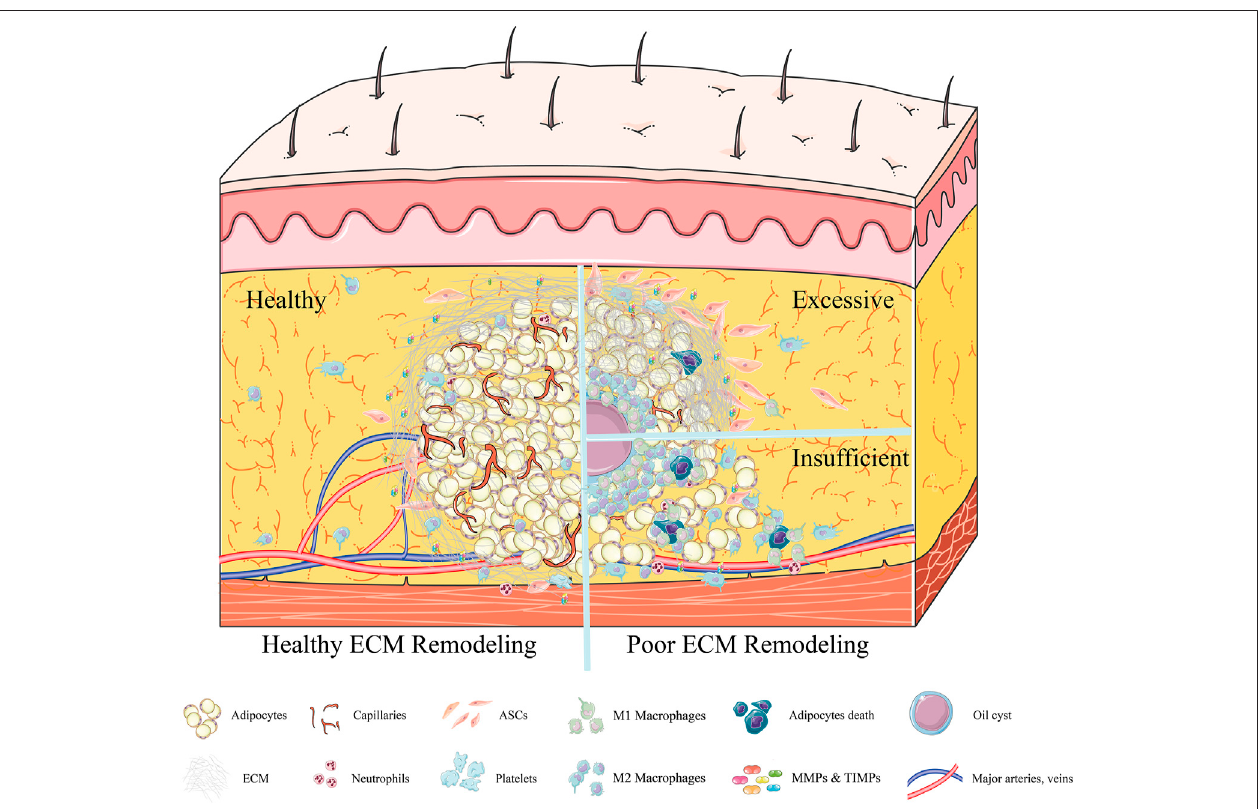
FIGURE 2 | Adipose ECM remodeling ≥ 7 days after fat grafting. In an environment of healthy adipose ECM remodeling, the establishment of a new vascular network is accompanied by gradual thickening of the fragile collagen fi bers, forming a complete ECM framework ( left ) . Almost all adipocytes were embedded in this newly formed cytoskeleton, after which the in fl ammation subsides gradually. By contrast, in an environment of poor adipose ECM remodeling ( right ) , excessive deposition ofECM isobserved, increasing adipose tissue stiffness ( right, above ).Although high tissue stiffness can promote themigrationof ASCs,it will inhibit the formationofnewbloodvessels.Duetopoorneovascularization,oilcystsformandaresurroundedbymacrophages.Alternatively,theinsuf fi cientsynthesisofECM( right, below )canresultinadiposelobulesnotbeingtightlyembedded intheECMframework.These fl oatingfatcellswillreleaseoildropletsafter necrosis,recruiting anexcess number of macrophages and inducing chronic in fl